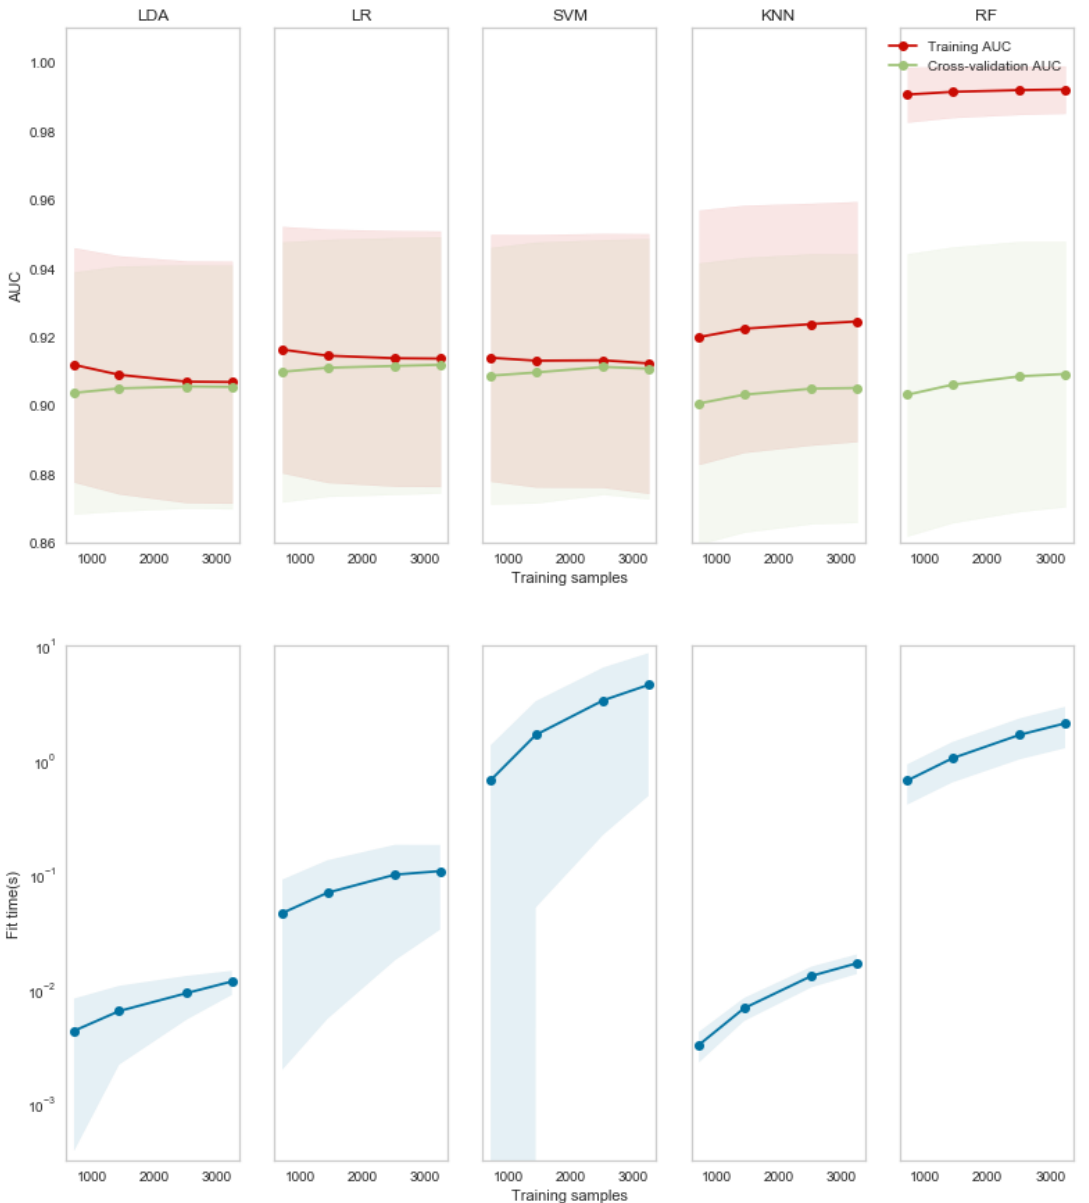
Figure 2. AUC (first row) and time for training (second row) for each of the five investigated algorithms (in each column) with different numbers of observations. The lines represent the population averages and the shadows the standard deviation.